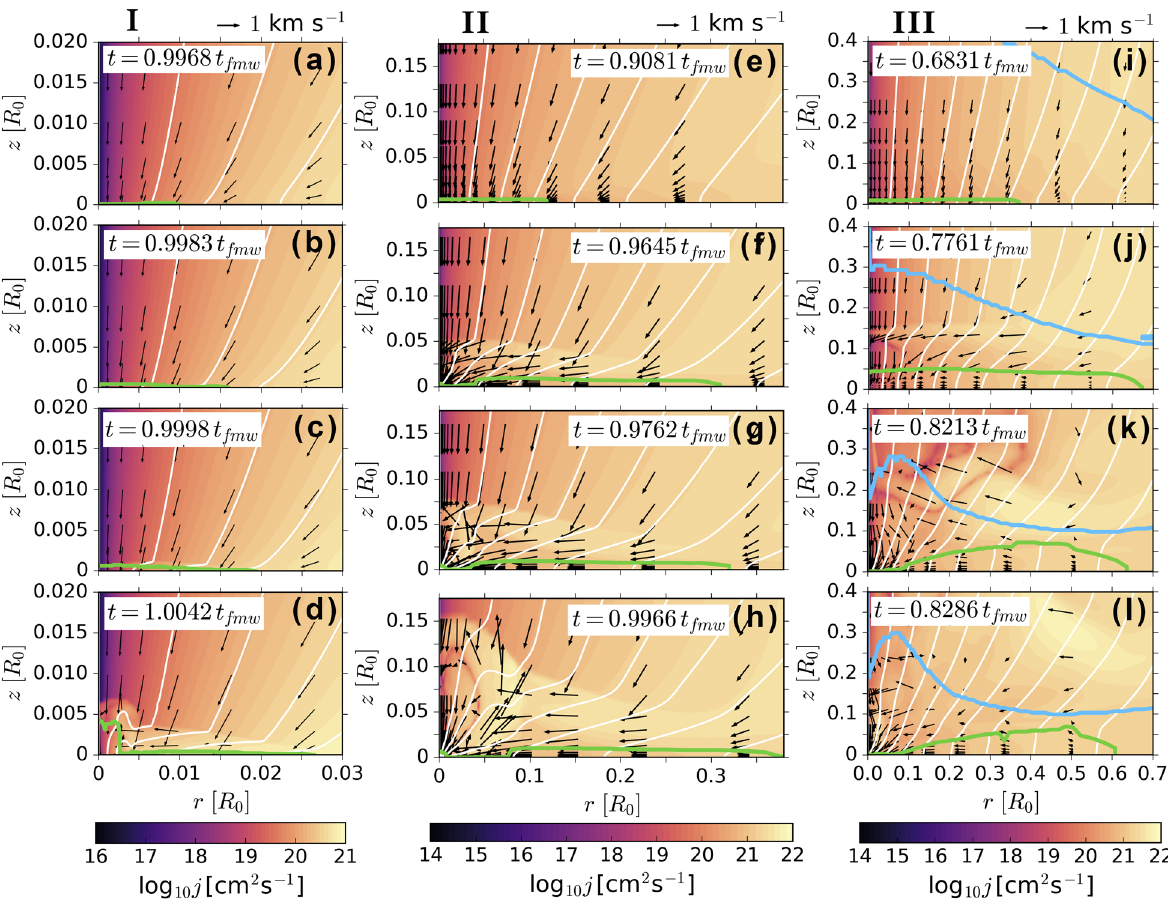
Figure 2: Distribution of the speci fi c angular momentum ( color fi lling ) , velocity fi eld ( arrows ) , and poloidal magnetic fi eld ( white lines ) in the simulations with ε 0.01 m = ( run I, left panels ) , ε 0.2 m = ( run II, middle panels ) , ε 0.6 m = ( run III, right panels ) at di ff erent time moments after the primary disk formation ( panels from top to bottom ) . The region near the primary disk is considered. Green line shows the border of the primary disk, and blue line is the border of the